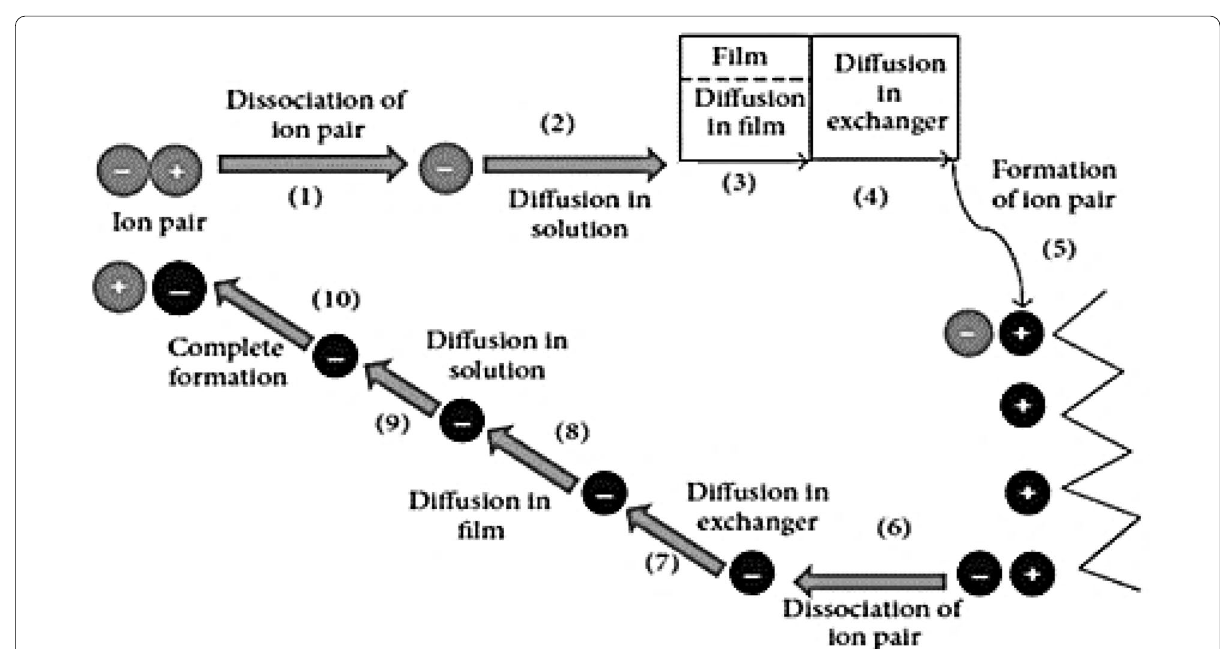
Fig. 4 The general step of ion exchange processes. Modified from Kumar and Jain (2013) with permission from Hindawi